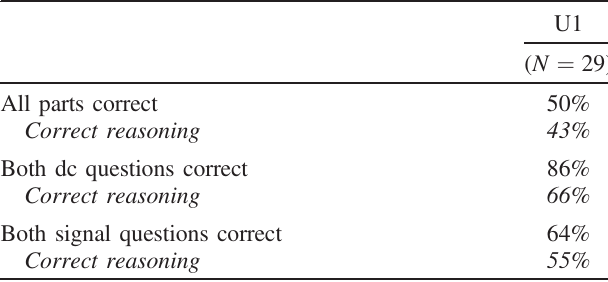
TABLE V. Overview of student performance on the revised amplifier comparison task (shown in Fig.